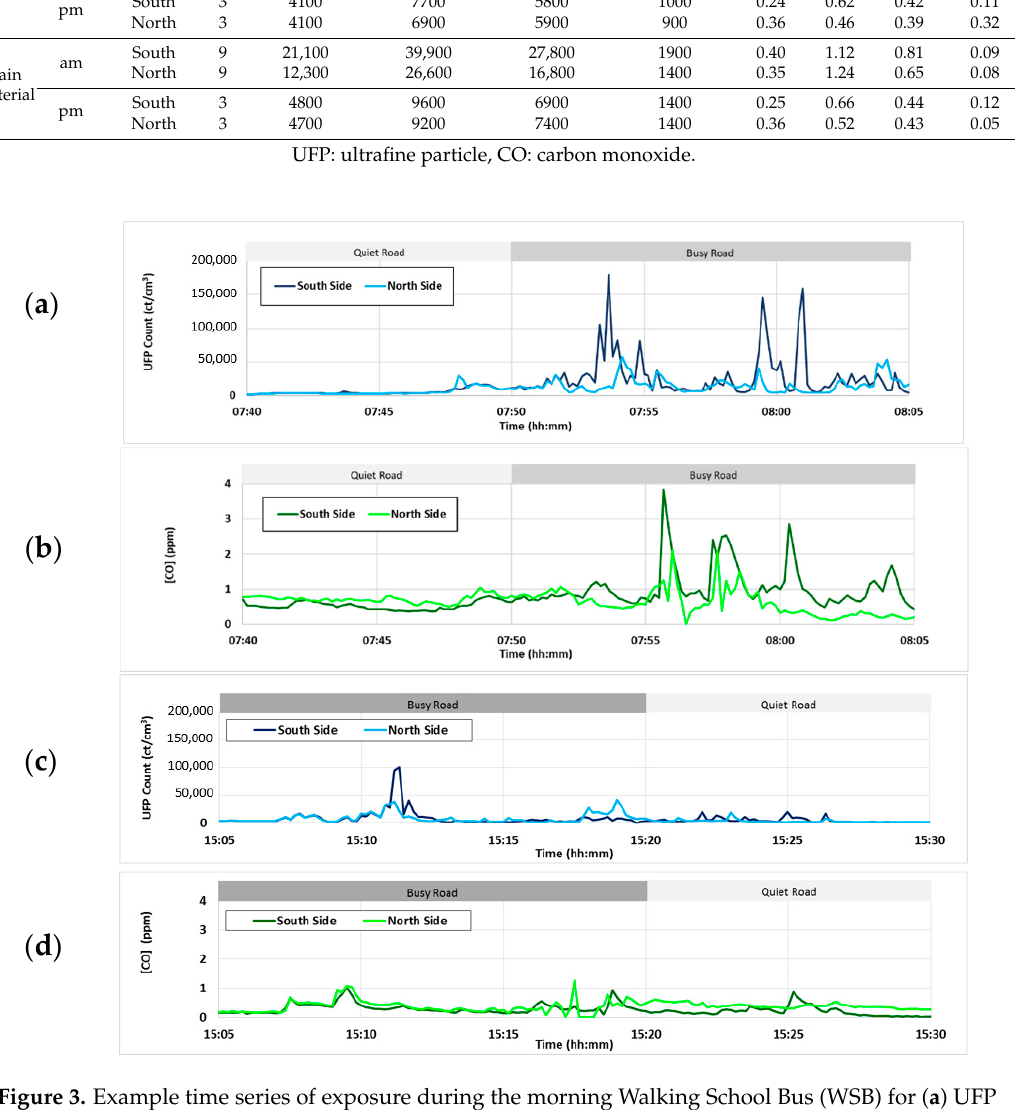
Table 3. Descriptive statistics for air pollution exposures on walking journeys. ‘All’ represents the complete route while ‘Main Arterial’ is restricted to observations made when travelling on the main arterial road segment.